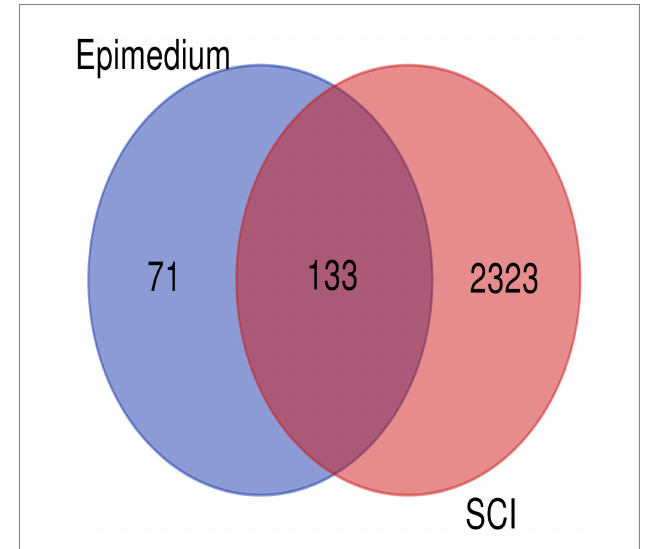
FIGURE 2 Venn diagram for EPI-and SCI-related targets.